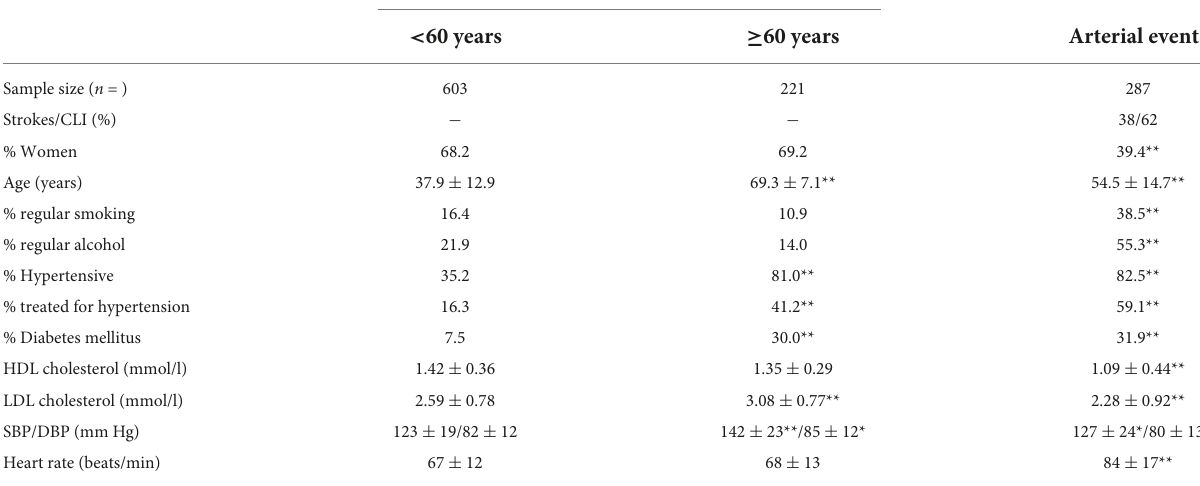
TABLE 1 Participant characteristics.